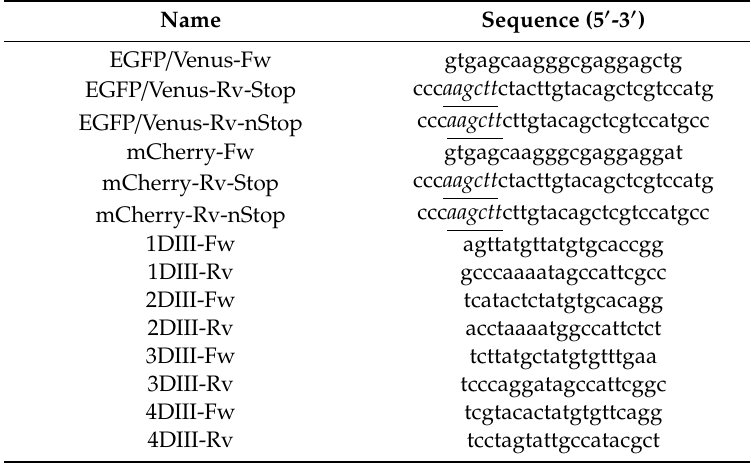
Table 1. Primers used in this